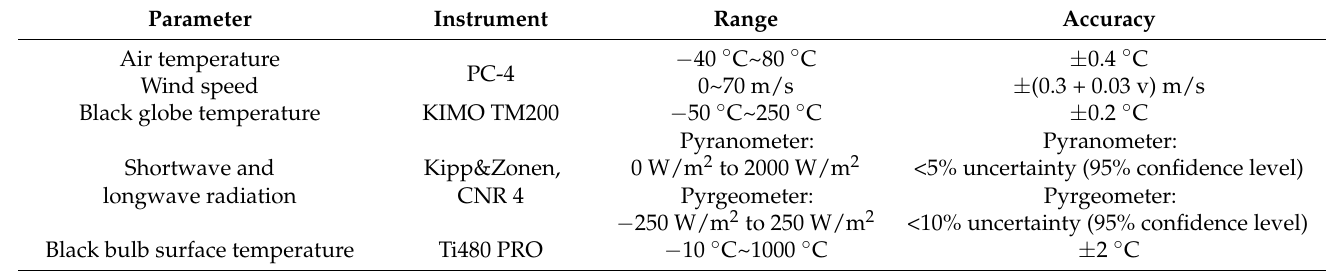
Table 2. Instrumentation used for measurement of indoor physical